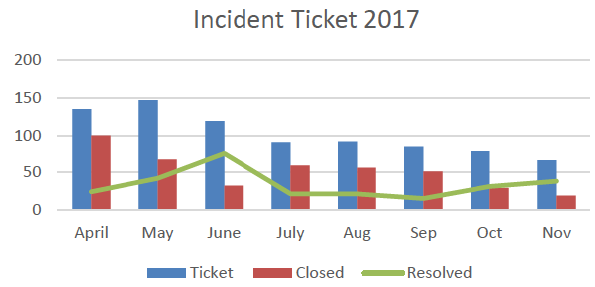
Figure 2: Incident Ticket Trend after Go Live April